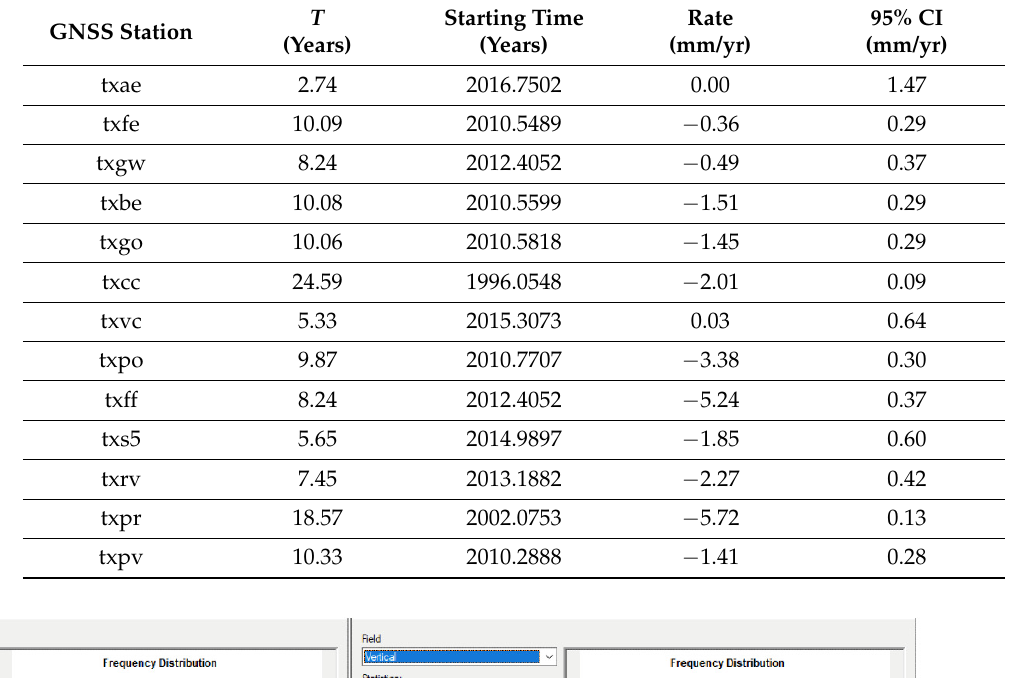
Table A4. List of GNSS stations, their starting time (years), time span (T; years), rates (mm/yr), and 95% confidence interval (CI). No significant variability was observed in the reported rates with time.